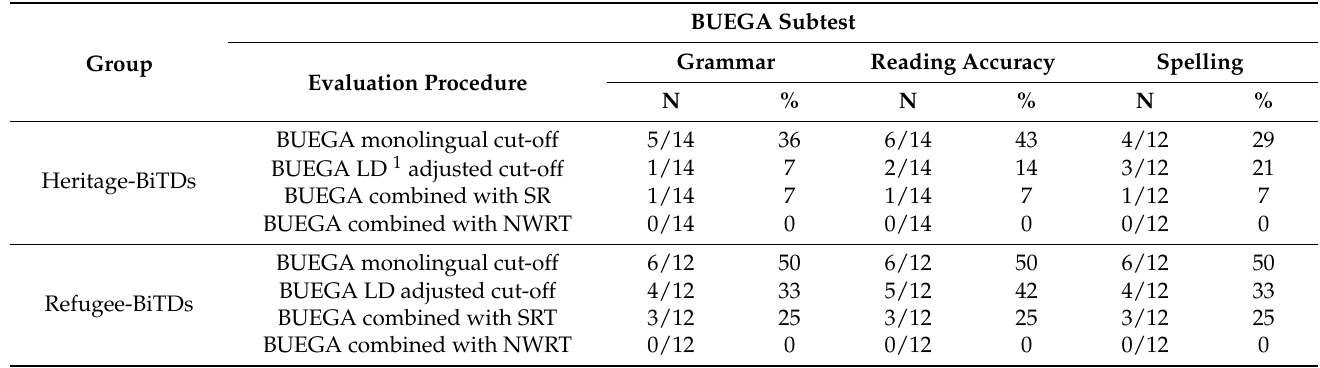
Table 3. Proportion of BiTD children identified as language impaired using single (without and with dominance adjustment) and combined measures (total Ns and